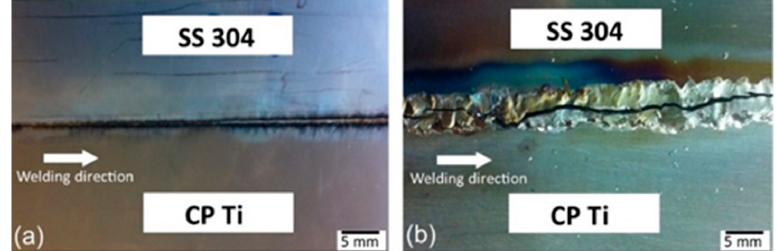
Figure 1. Optical macrographs showing commercially pure titanium (CPTi) and stainless steel 304 (SS304) interface following welding by ( a ) laser beam welding (LBW) and ( b ) gas tungsten arc welding (GTAW).